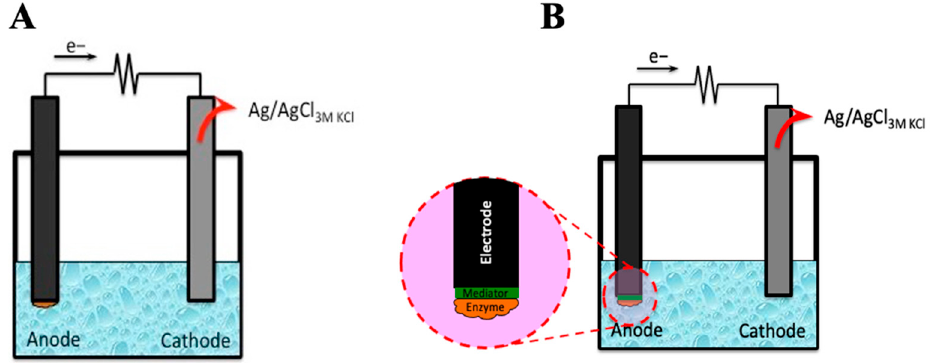
Figure 1. Principal scheme of ( A ) enzyme-based mediator-free biofuel cell and ( B ) mediated enzyme-based biofuel cell.